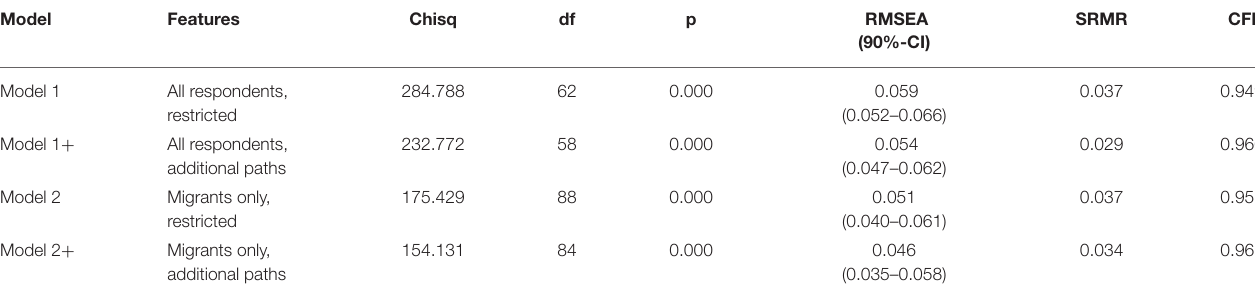
TABLE 2 | Fit measures of empirical models.